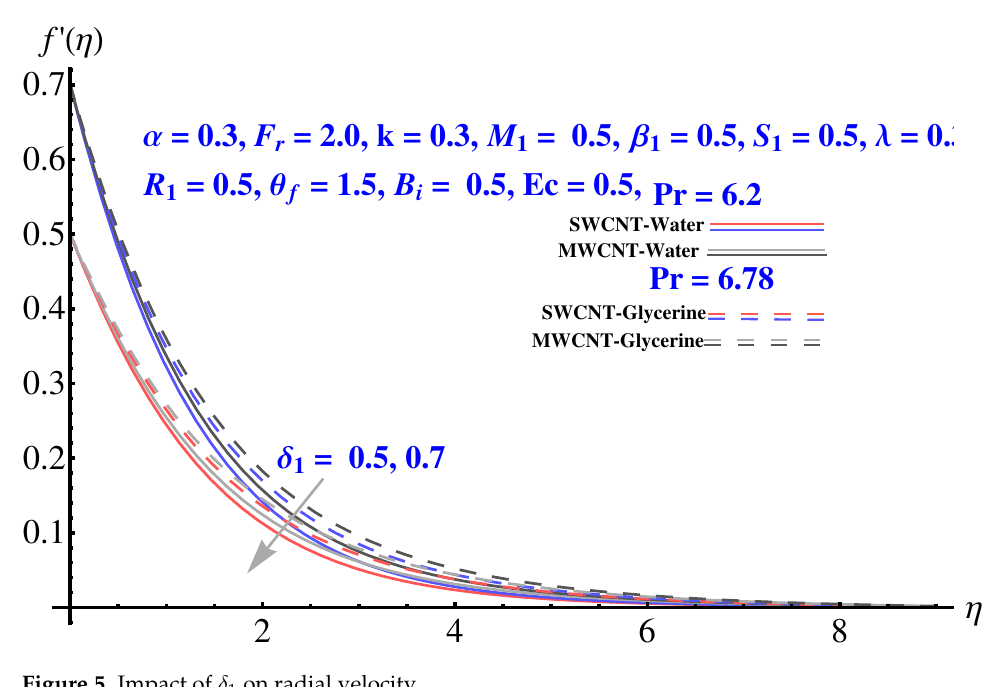
Figure 5. Impact of δ 1 on radial